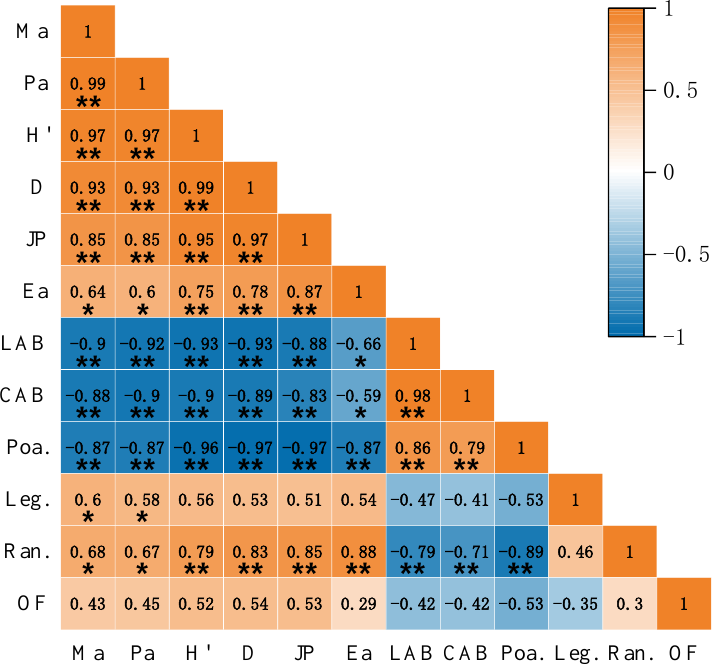
Figure 9. Heatmap for correlation analysis of community species diversity, biomass, and plant functional group importance values under N and P addition. Ma, Margalef richness index; Pa, Patrick richness index; H ’, Shannon‒Wiener diversity index; D, Simpson diversity index; JP, Pielou even- ness index; Ea, Alatalo evenness index; LAB, aboveground biomass of L. chinensis ; CAB, above- ground biomass of the community; Poa., the importance values of Poaceae plants; Leg., the im- portance values of Leguminosae plants; Ran., the importance values of Ranunculaceae plants; OF, the importance values of other families. * and ** represent a significant correlation at the 0.05 and 0.01 levels, respectively. 4. Discussion 4.1. Effects of N and P Addition on the Species Composition of Communities and Their Quantitative Characteristics The relationships between species changes in habitats after nutrient addition. In this experimental study, no clear pattern of changes in the importance values of individual species was found in the meadow grassland communities after fertilization, but the divi- sion of species into higher plant families revealed that the importance values of functional groups composed of different plant species changed significantly with the addition of ni- trogen and phosphorus. Phoenix et al. [32] have shown that anthropogenic increases or decreases in nutrients in ecosystems can have a wide range of effects on terrestrial plant communities, while Reich et al. [33] and Suding et al. [34] have suggested that some spe- cies and functional groups are more susceptible to decline than others in the presence of increased resources. The height, density, and cover of the dominant species L. chinensis in the plant community of this experimental sample plot increased significantly with the ap- plication of nitrogen and phosphorus. The importance value also increased and enhanced